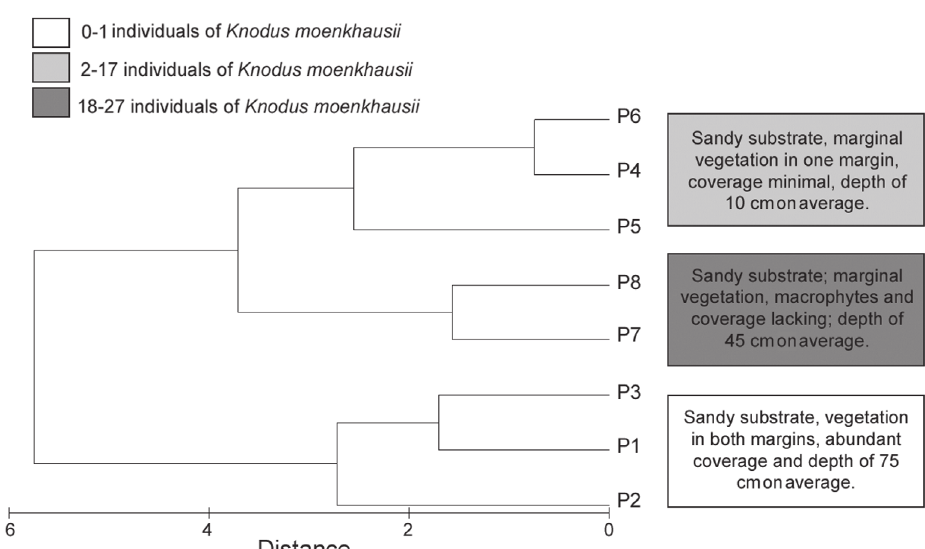
Figure 3. Dendrogram showing the three clusters obtained by the Euclidean Distance, considering four environmental descriptors (coverage, depth, substrate, and submerged vegetation) in a microhabitat scale analysis of K. moenkhausii occurrence based on eight points of observation (P). Species abundances were posterior plotted in the figure.